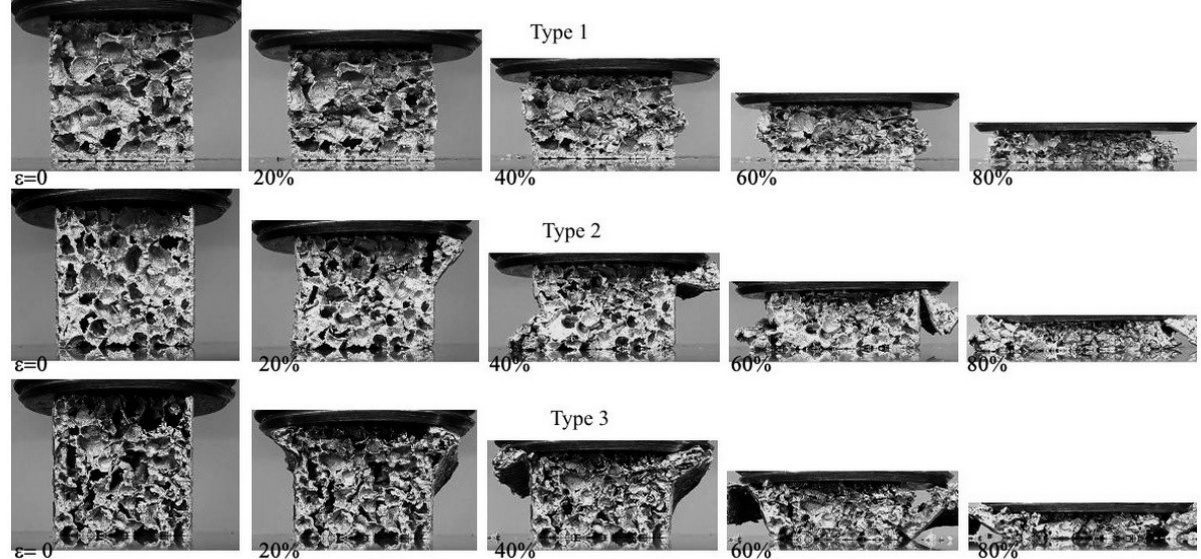
Figure 5: Images illustrating the deformation behavior of unreinforced (type 1), transverse reinforced (type 2), and longitudinal reinforced (type 3) foam samples at 0.025 s –1 strain